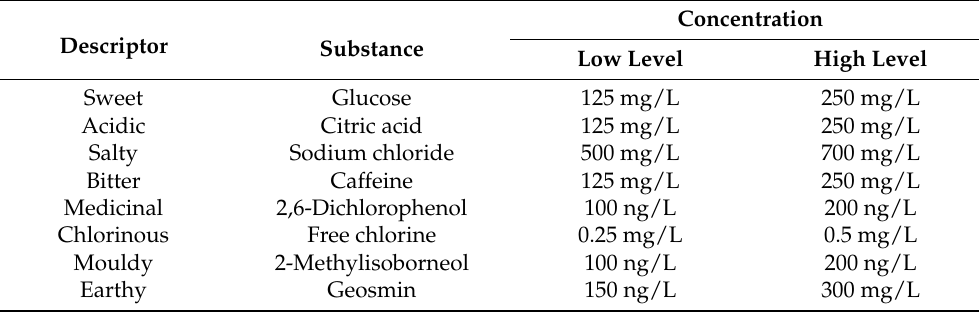
Table 2. Concentration levels of the chemical descriptors for the 16 synthetic water